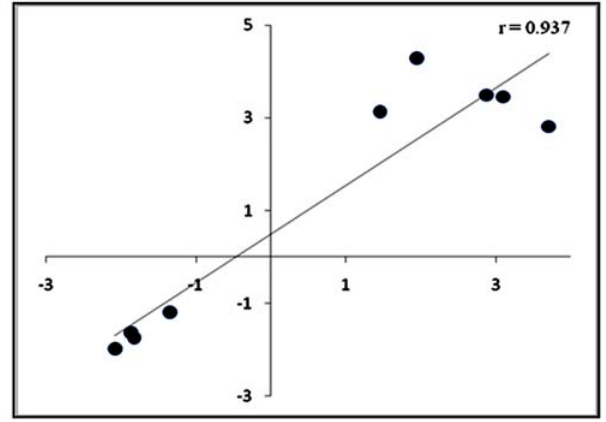
Figure 4. Correlation between microarray and real time PCR data. The scatter plot compares mean expression of RA patients/ controls ratio for nine genes. Each point represents the RA patients/ controls ratio from the microarray (y axis) and real time PCR (x axis). Pearson correlation coefficient is indicated in the scatter plot. doi:10.1371/journal.pone.0006803.g004 PLoS ONE |